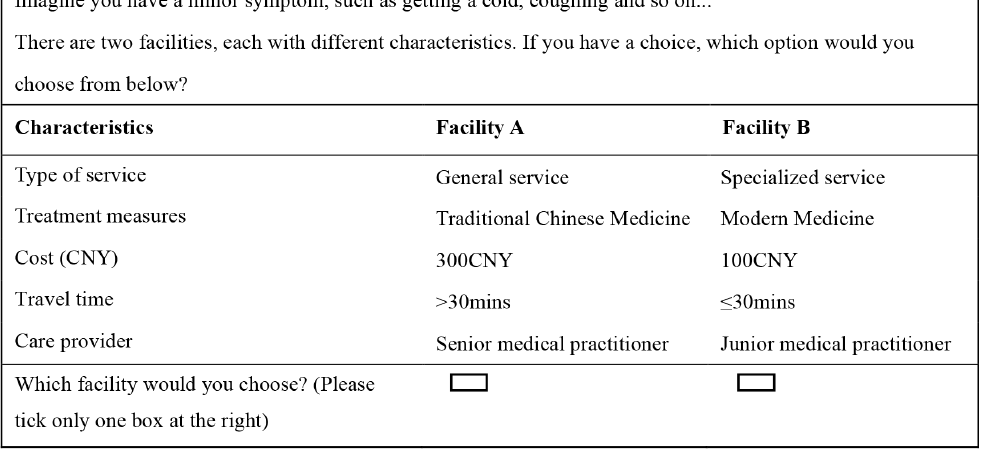
Figure 1. Example of a choice set.